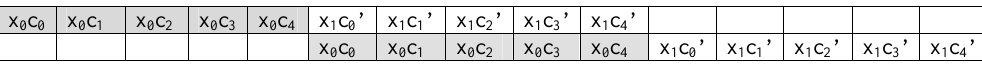
Figure 11: Secrecy of